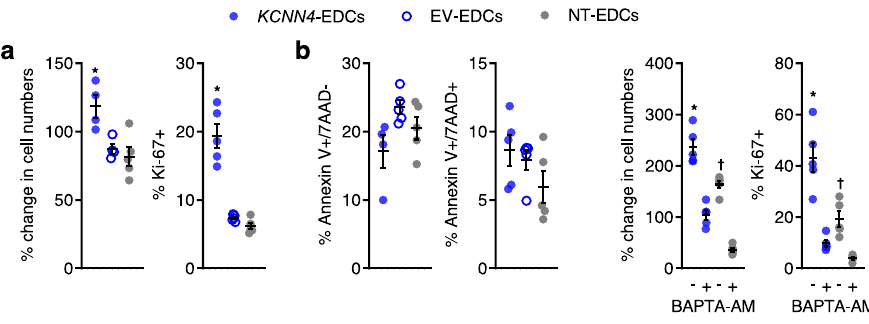
Fig. 4 Effect of KCNN4 overexpression on EDC phenotype after 24 h exposure to ischemia-mimicking media culture conditions. a Increasing I KCa3.1 boosts EDC cell numbers ( n = 5 biological replicates/group). * P < 0.05 vs. EV- and NT-EDCs. KCNN4 overexpression increases the proportion of EDCs actively proliferating ( n = 5 biological replicates/group). * P < 0.05 vs . EV- and NT-EDCs. b Increasing I KCa3.1 had no effect on the ability of EDCs to withstand apoptosis as indicated by expression of apoptotic (Annexin V + /7AAD − ; n = 5 biological replicates/group except KCNN4 -EDCs where n = 4 biological replicates) and necrotic (Annexin V + /7AAD + ) markers ( n = 5 biological replicates). 7AAD 7-aminoactinomycin. c Calcium chelation using BAPTA-AM reduces EDC cell numbers ( n = 5 biological replicates / group) and the proportion of EDCs actively proliferating ( n = 5 biological replicates/ group). All data are presented as individual and mean values ± SEM. Signi fi cance is indicated in all panels using * P < 0.05 vs. KCNN4- EDCs exposed to